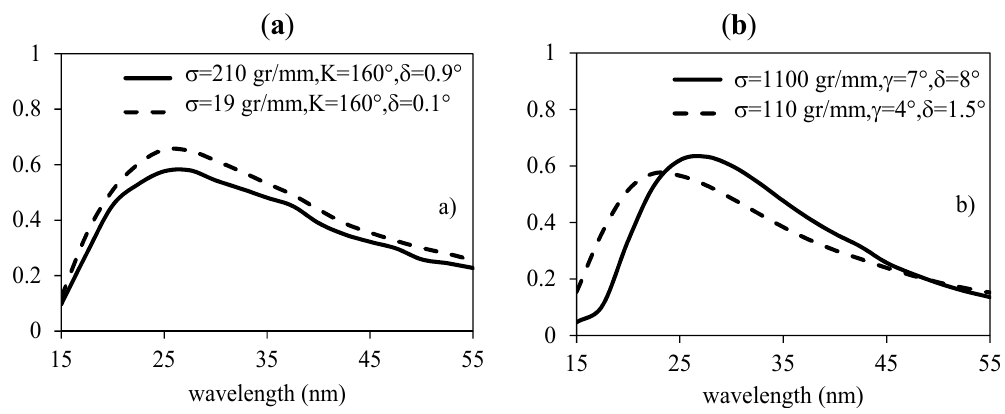
Figure 4. Efficiency curve of the gratings with the parameters listed in Table 1: ( a ) CDM; ( b ) OPM.